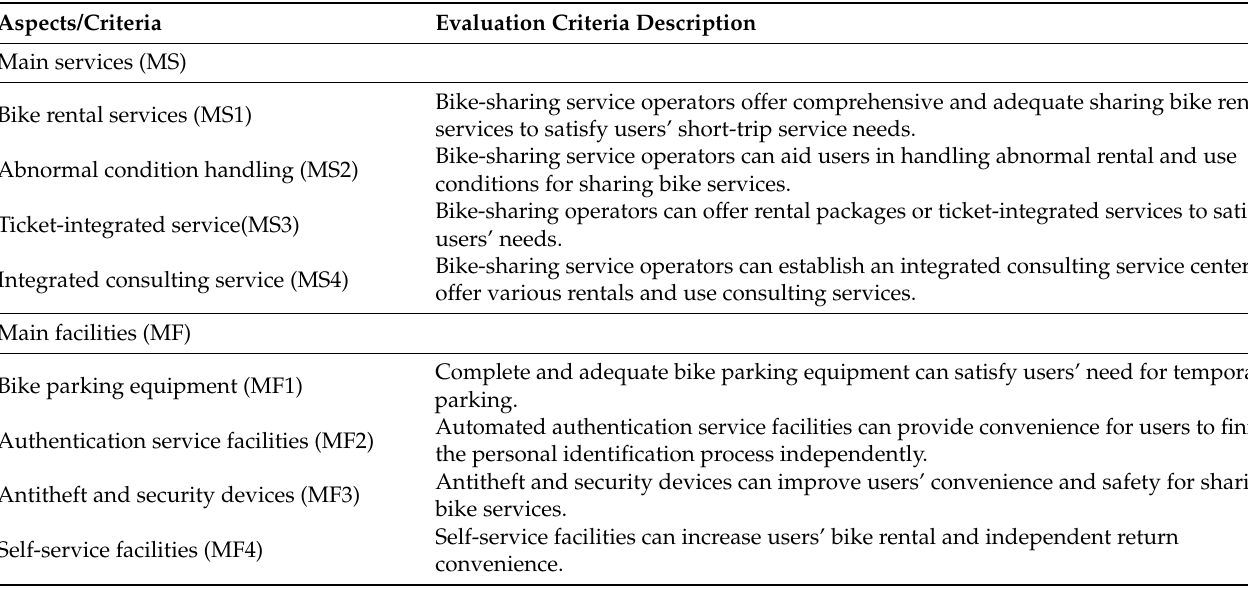
Table 1. Description of value drivers forces for public bike-sharing service systems